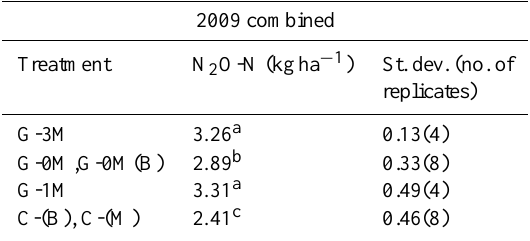
Table 4. Cumulative N 2 O-N losses (kgha − 1 ) over 204 days in 2009 in grass-clover treatments and cereal reference plots (treatments having no differences in 2009 were combined).